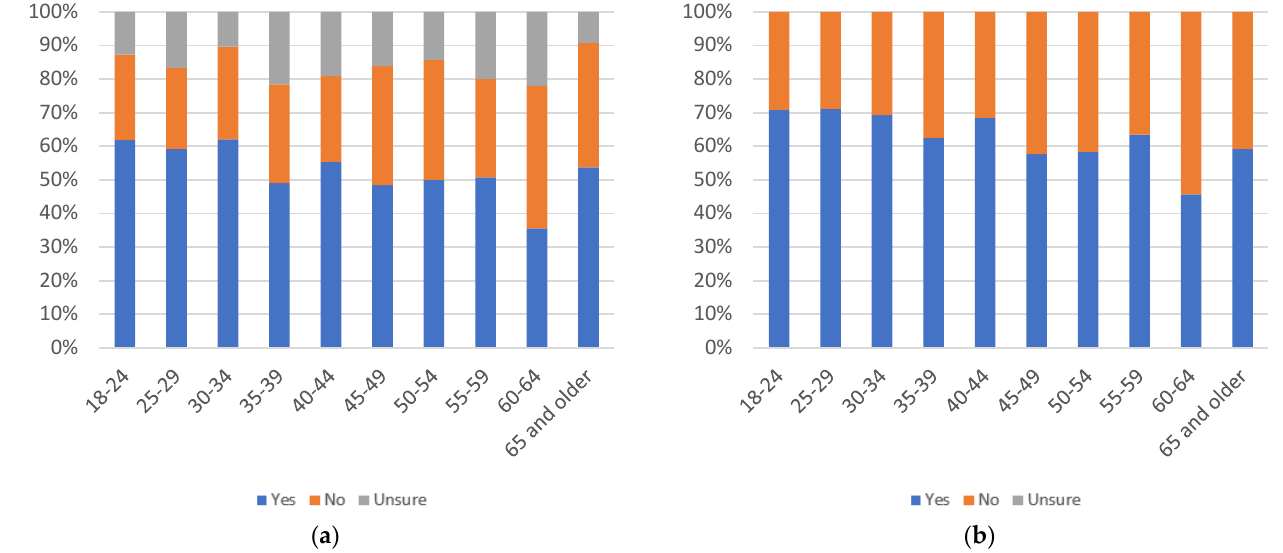
Figure 5. Label helpfulness, by age group: ( a ) with uncertain respondents (left) and ( b ) without uncertain respondents (right).